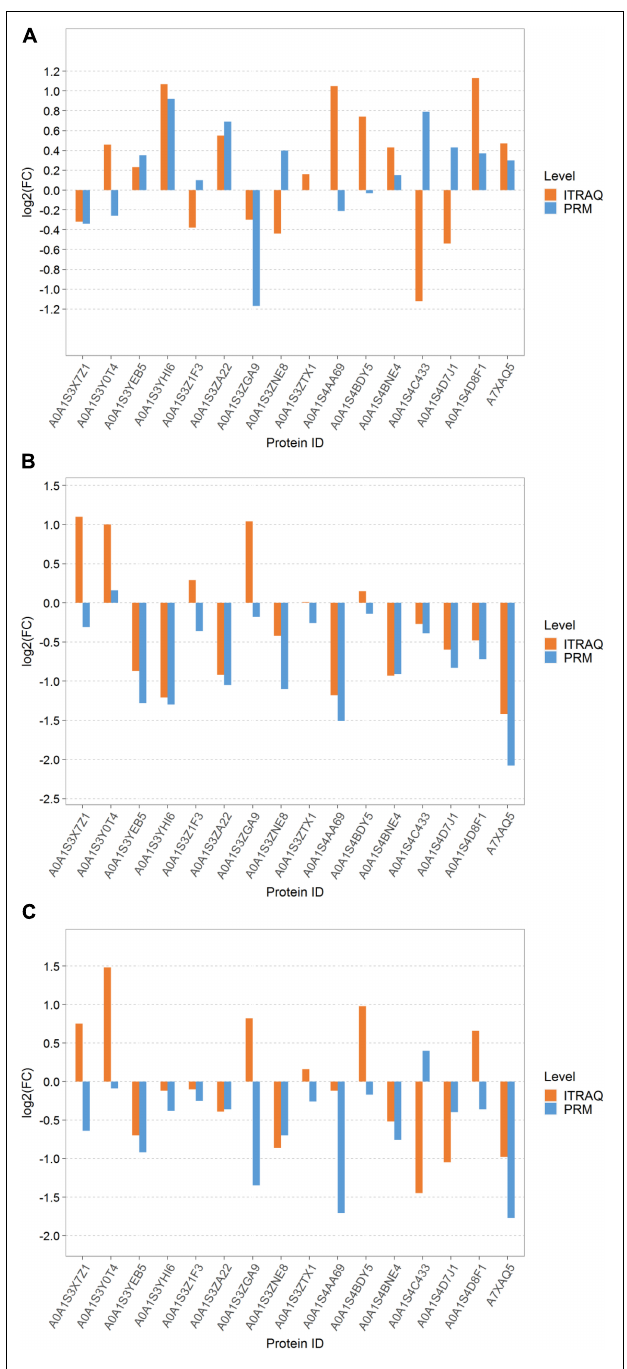
FIGURE 8 | Column map of parallel reaction monitoring (PRM) quantitative protein differences among different samples. (A) LS vs. PS; (B) LS vs. RS; and (C) PS vs. RS. The proteins corresponding to the column on the upside of the transverse axis 0 represent upregulated proteins, the proteins corresponding to the column on the underside of the transverse axis 0 represent downregulated proteins, numbers on columns represent multiple differences (non-logarithmic), for example: if the number in the underside column is 2, the WM is two times as much as the IM in the expression level; if the number in the upside column is 2, the WM is 0.5 times as much as the IM in the expression level.